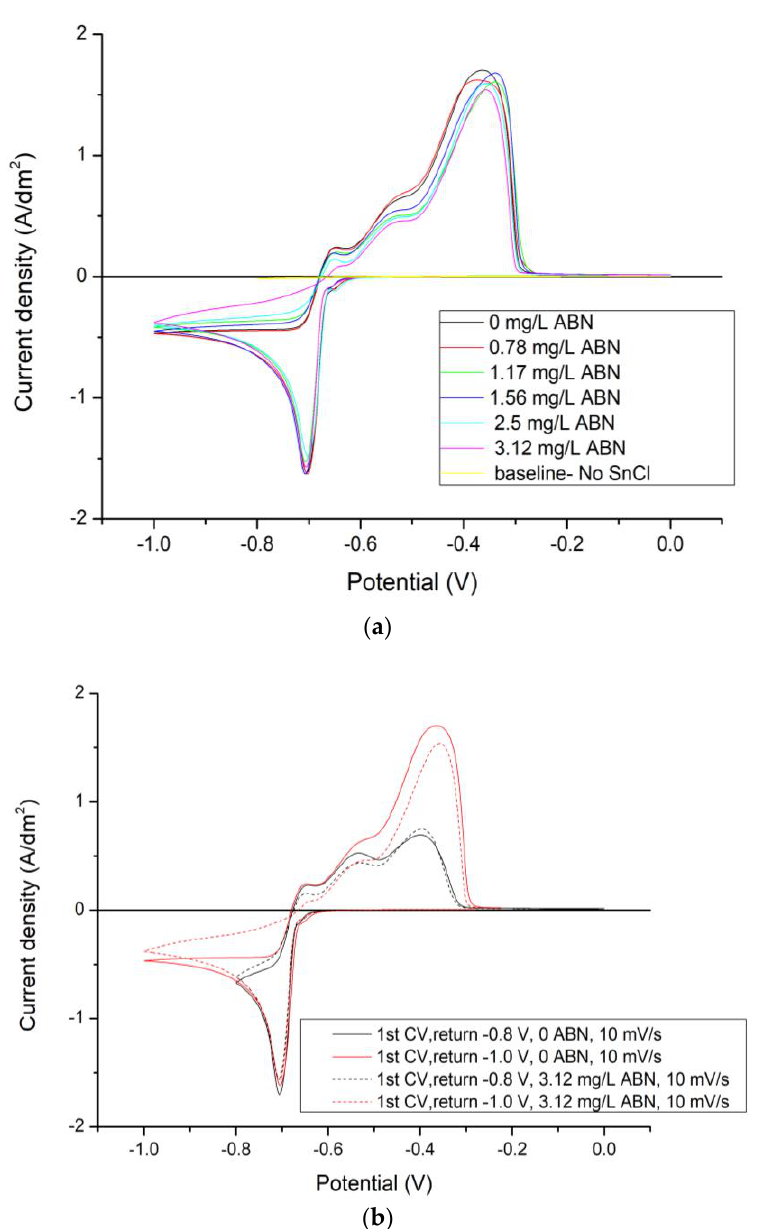
Figure 4. Cyclic voltammograms in the chloride electrolyte showing the creation of the oxide layer (peak I and II) and bulk Sn dissolution (peak III) for: ( a ) different ABN concentration. With the increased additive concentration both oxide and Sn layer are hindered, ( b ) for two different cathodic return points − 0.8 and − 1 V. At the higher cathodic return potential, more Sn is deposited while the oxide layer remains the same as for the − 0.8 V.